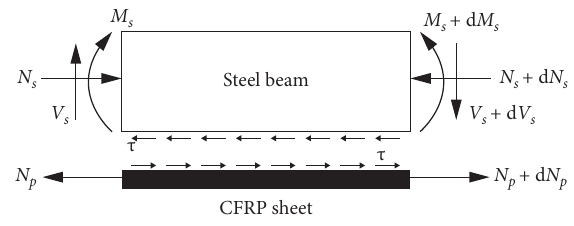
Figure 1: The element